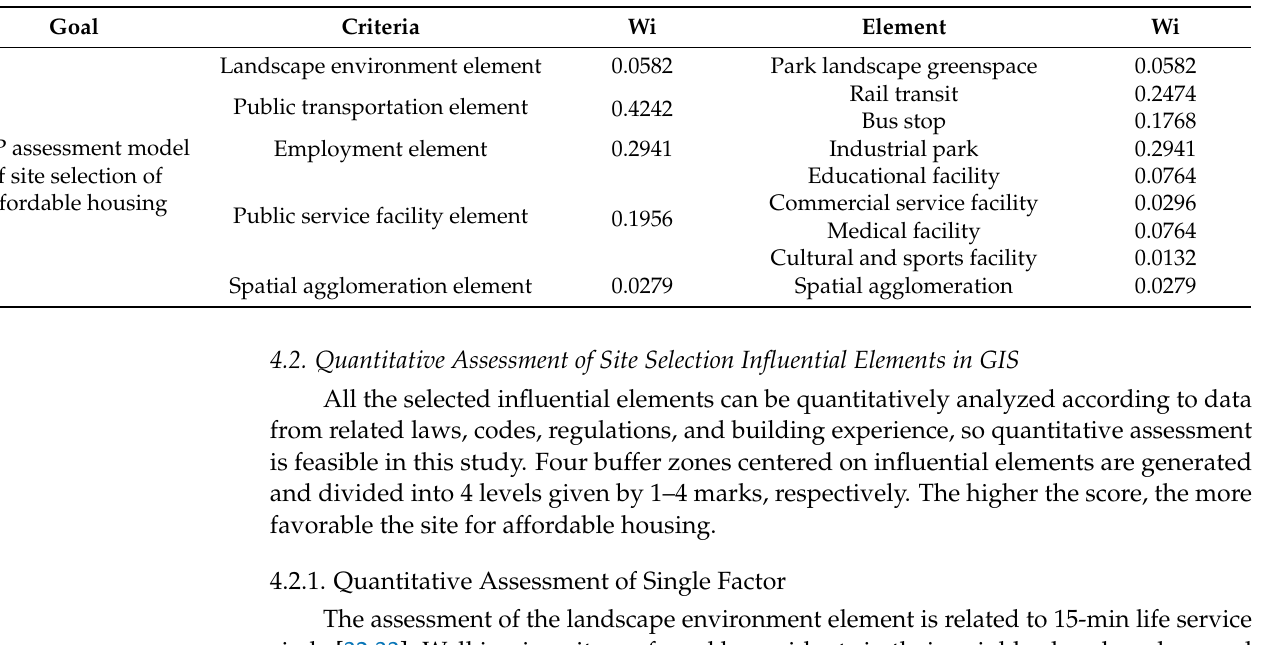
Table 10. Weight distribution of site selection AHP assessment